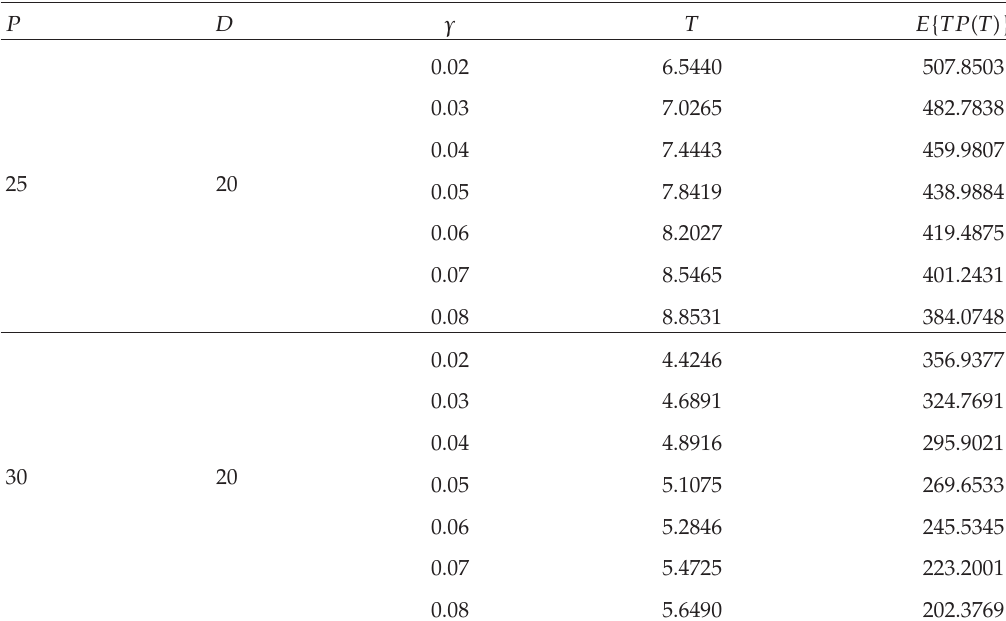
Table 4: Results due to di ff erent γ